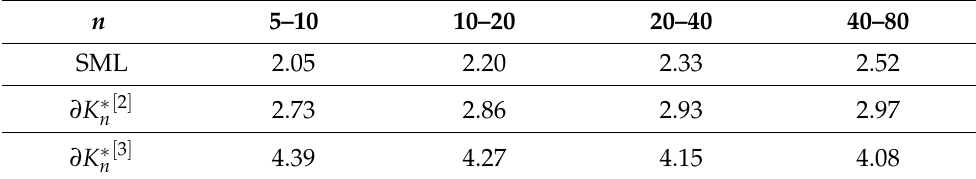
Figure 3. Semilinear equation with f ( t , u ) = ( x 2 u x ) x + h ( t ) and GRK4T integrator, with Dirichlet boundary conditions. Table 3. Orders for global error, GRK4T and f ( t , u ) = ( x 2 u x ) x + h ( t ) with Dirichlet boundary conditions. SML stands for ‘standard method of lines’ and ∂ K ∗ n [ 2 ] , ∂ K ∗ n [ 3 ] for the different variations of the technique suggested in this